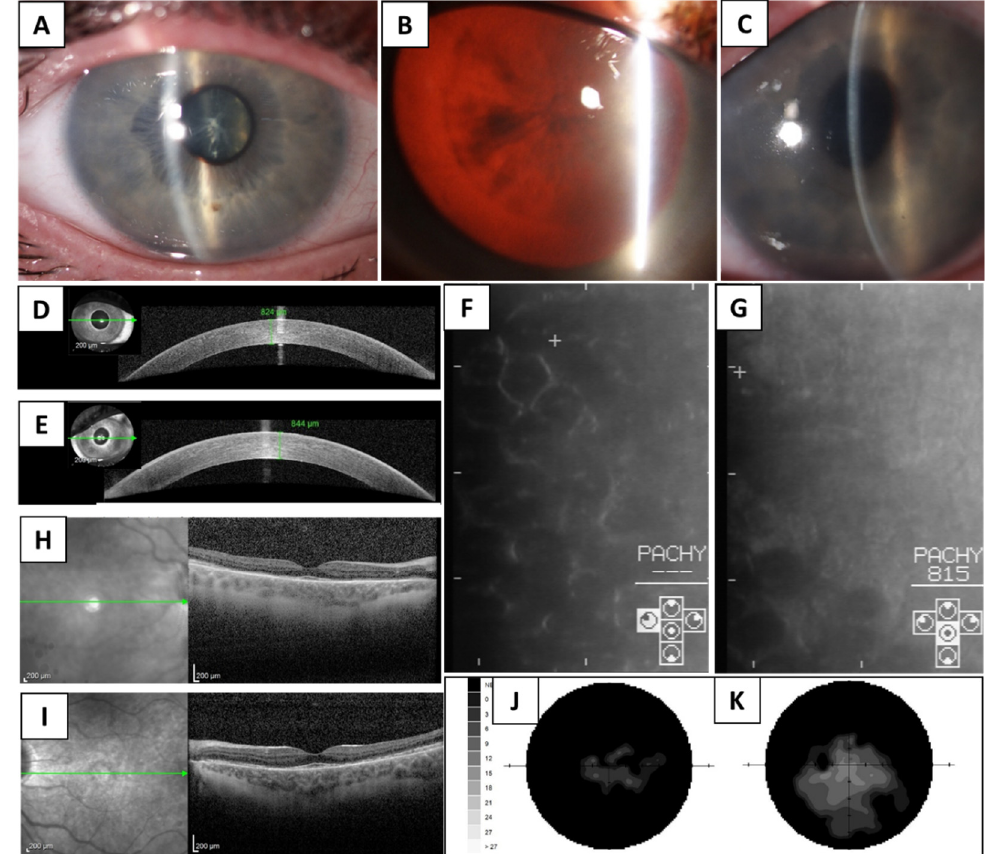
Figure 1. Panocular involvement in a case with Kearns-Sayre syndrome spectrum. Corneal oedema in the right eye ( A ), nuclear cataract in the right eye ( B ), corneal oedema in the left eye (narrow beam) ( C ), SD-OCT imaging of the right ( D ) and left cornea ( E ) documenting increased central corneal thickness). Specular microscopy images showing corneal endothelial surface with beaten metal appearance (quality is decreased due to stromal haze) in the right ( F ) and left eye ( G ), SD-OCT imaging of the macula documenting disintegration of the photoreceptor layer (arrow), in the right ( H ) and left eye ( I ), static perimetry showing visual field loss in the right ( J ) and left ( K )